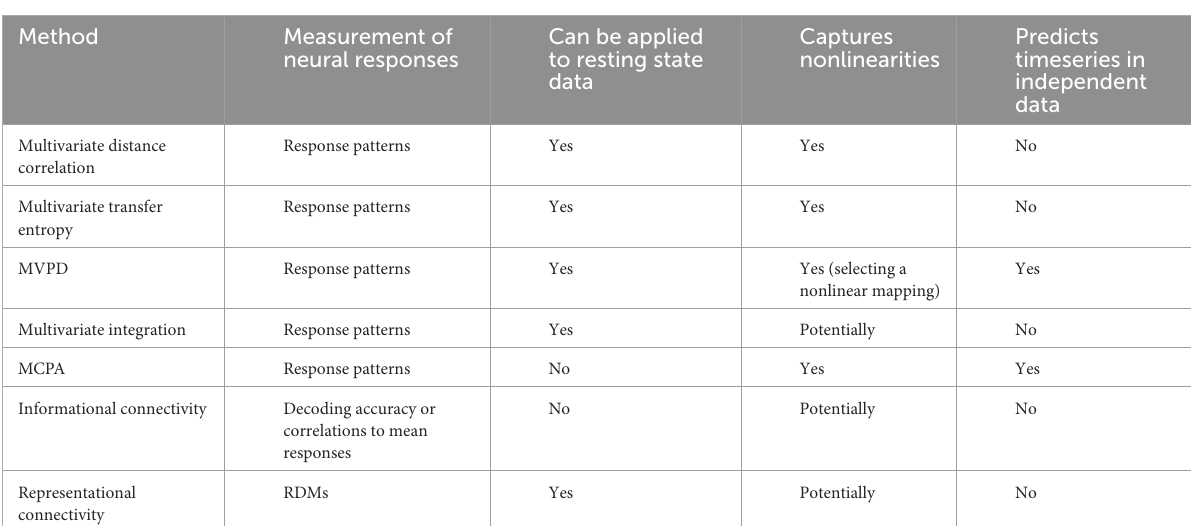
TABLE 1 Summary of different multivariate connectivity